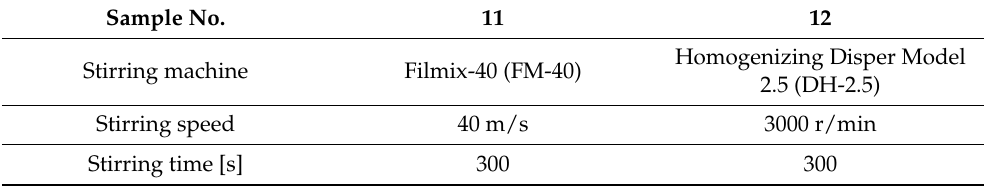
Table 3. Stirring machine and speed of the samples to make highly scattering coefficient medium. Sample No.